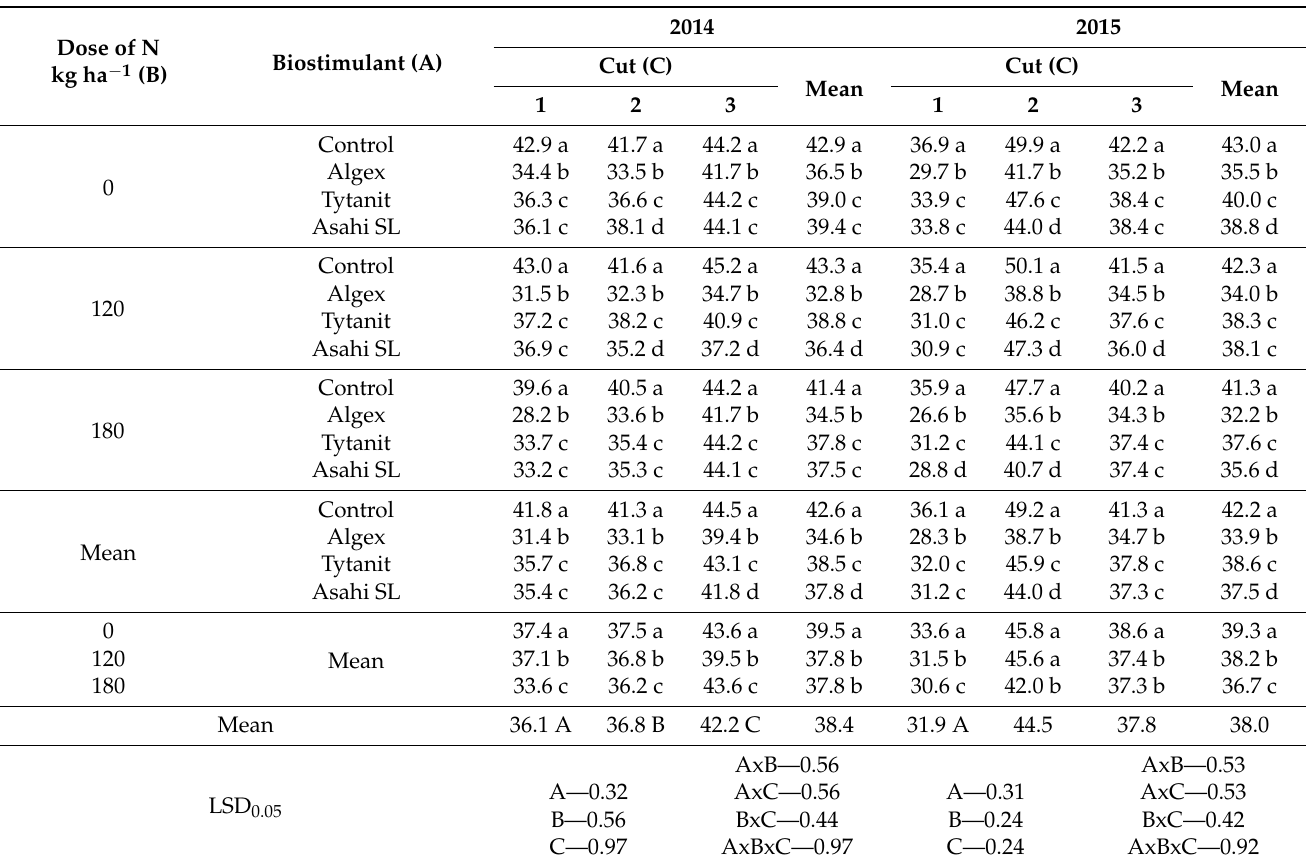
Table 4. The effect of the biostimulants on content of acid detergent lignin (ADL) in Italian ryegrass by cut and nitrogen fertilization (g kg − 1 DM). Dose of